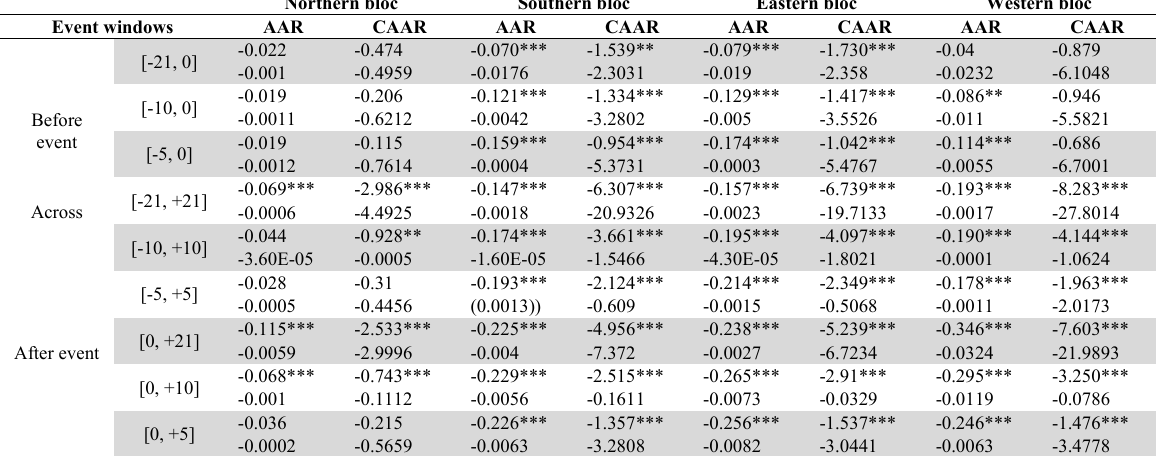
Note: Each bloc is composed of three countries except the Southern bloc, which consists of five. The AAR is generated from the difference between actual return and expected return. The market model is used to generate the expected return. The numbers in parenthesis denote standard deviation while ***, ** denote 1% & 5% significance level respectively.